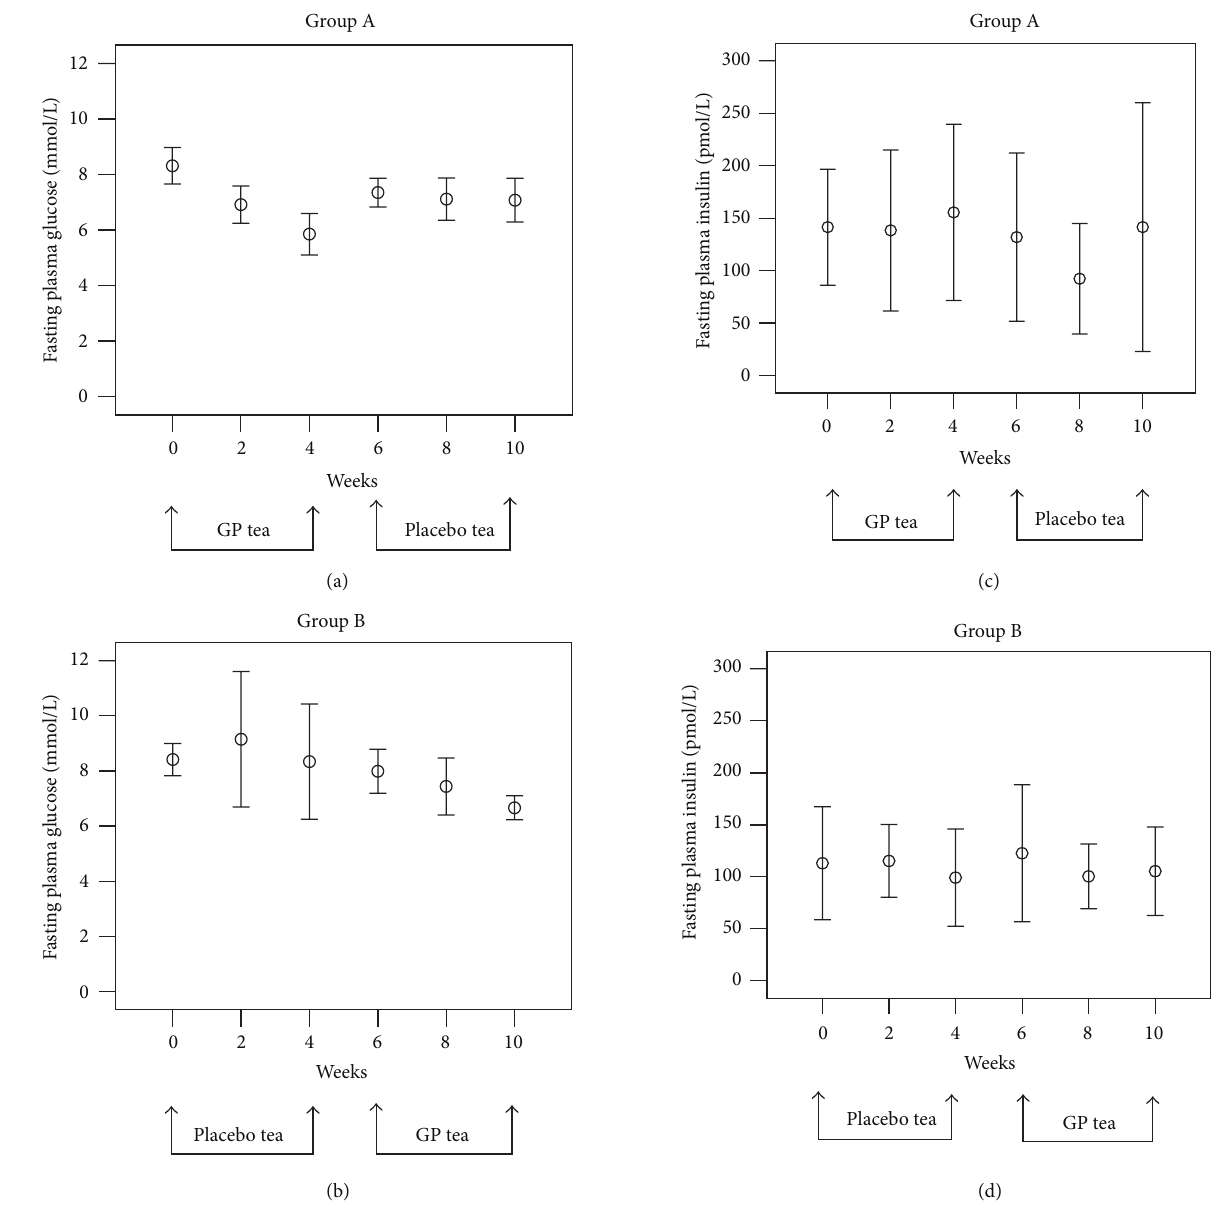
Figure 2: Fasting plasma glucose (mmol/L) and insulin (pmol/L) levels in Group A ((a) and (c)) and Group B ((b) and (d)). Means ± SD ( 𝑛 = 8 in each